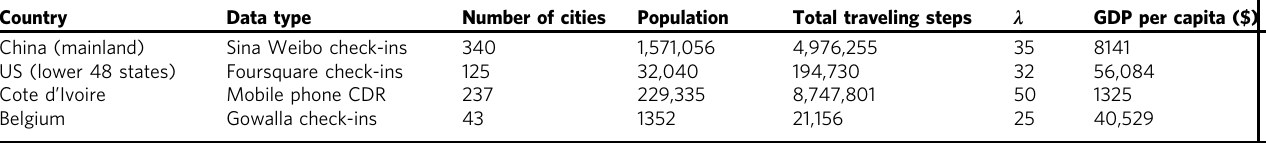
Table 1 Description of empirical data sets Country